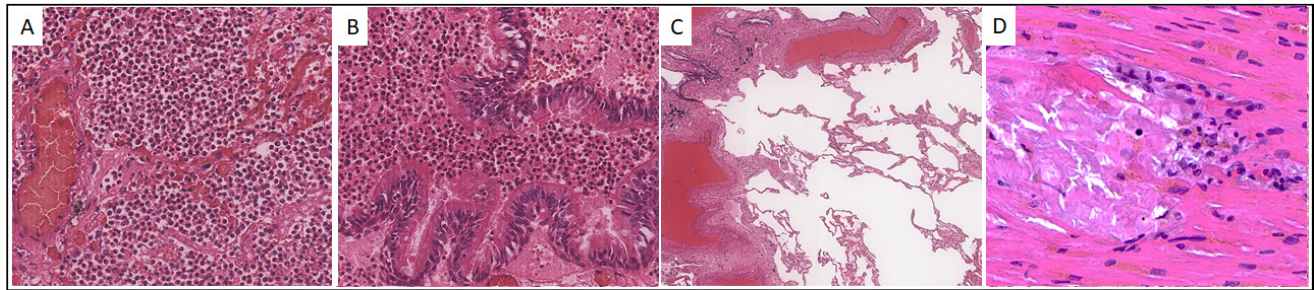
Figure 1. Histological picture of the lungs and myocardium of patient No. 23. ( A , B ). Intraalveolar and intrabronchiolar polymorphonuclear leukocyte infiltration, ×200; ( C ). Areas of peribronchiolar and perivascular fibrosis, and emphysema ‐ tous enlargements, ×40; ( D ). Myocardial microinfarctions with mononuclear inflammatory infiltration, ×400. Hematoxylin ‐ eosin